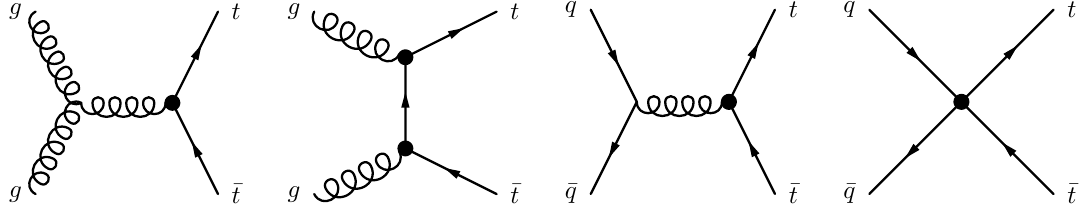
Figure 1 . Examples of Feynman diagrams contributing to top pair production in SMEFT at leading order. The dots indicate possible insertions of a dimension-6